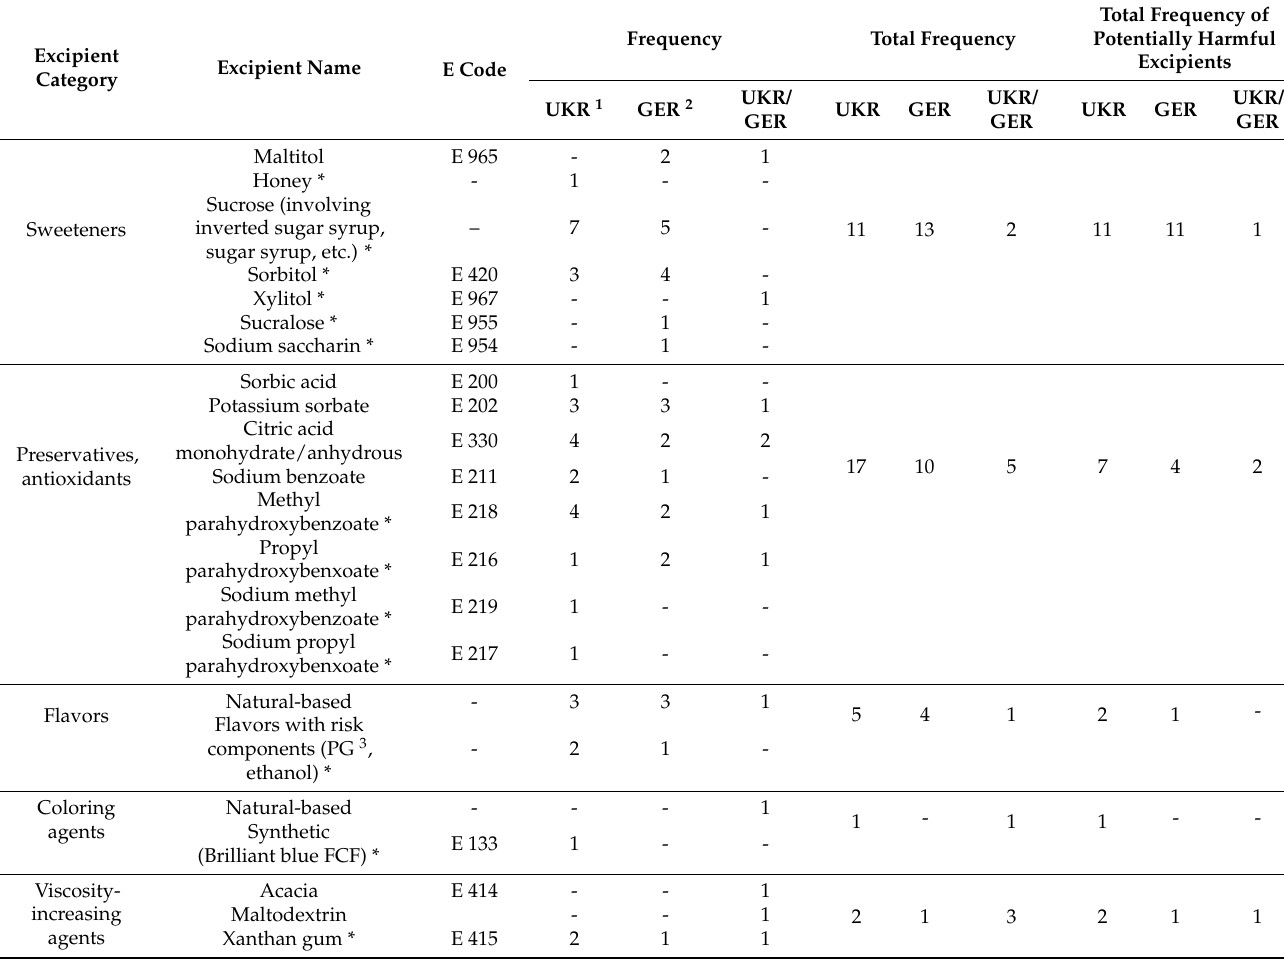
Table 1. Analysis of excipients safety in analyzed samples of pediatric phytomucolytic syrups marketed in Ukraine ( n = 10), in Germany ( n = 10), and syrups with equivalent authorization in Ukraine and Germany ( n = 2).